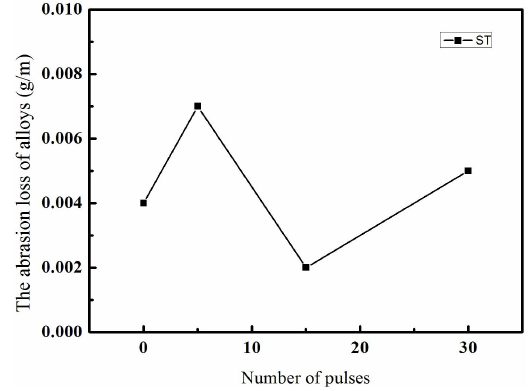
Figure 9: The abrasion loss of alloys for Zr-17Nb alloy surface before and after HCPEB